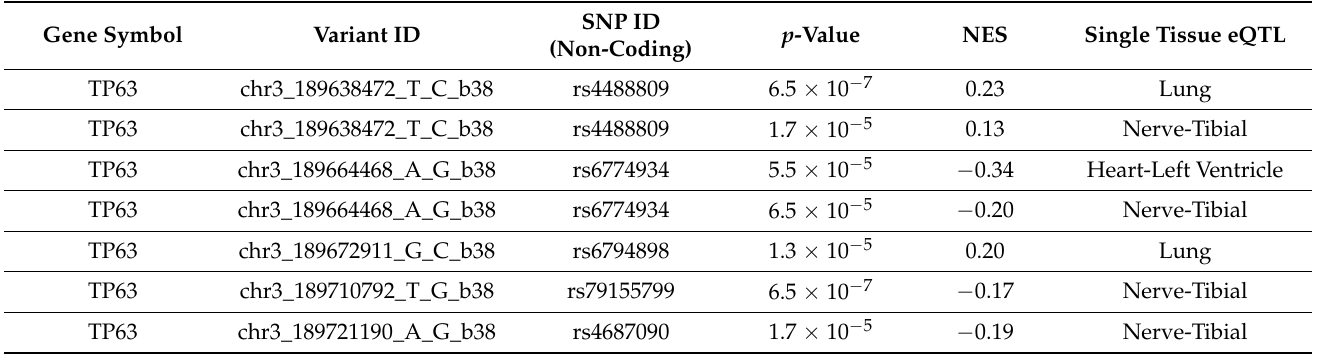
Table 5. eQTLs prediction of non-coding SNPs in GTEx